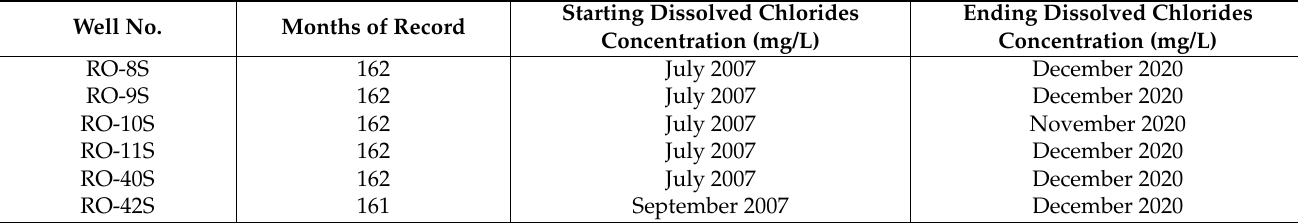
Starting Dissolved Chlorides Ending Dissolved Chlorides Concentration (mg/L) Concentration (mg/L)